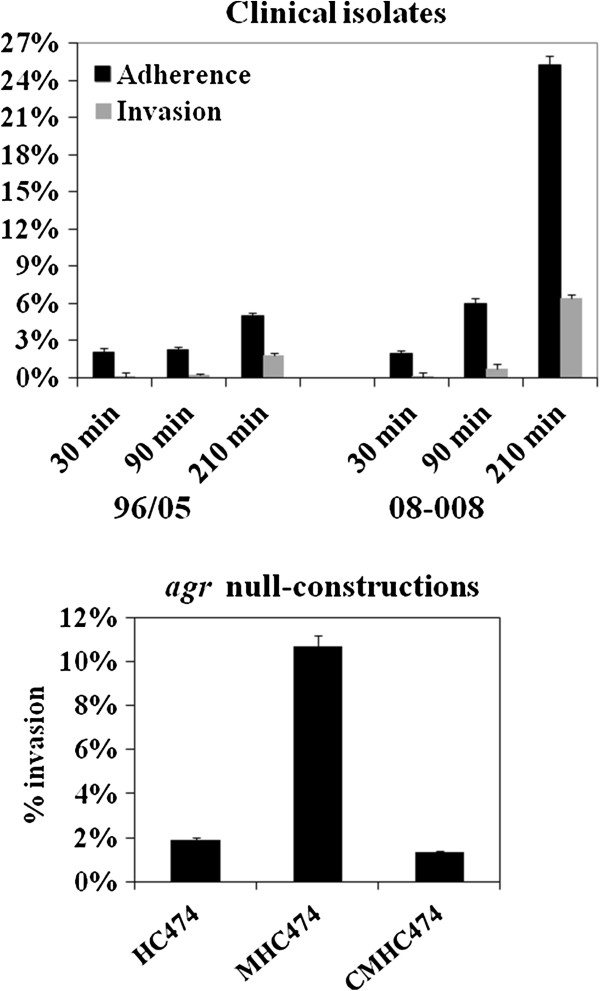
Adherence and invasion assays using human bronchial epithelial cell line (16HBe14o-). Top: 96/05 (agr-functional) and 08–008 (agr-dysfunctional). Bottom: Invasion assay was also determined after 3h30 min for the wild-type strain HC474, isogenic agr knockout MHC474 (Δagr::tetM) and the rnaIII-trans-complemented construction CMHC474 (Δagr::tetM, pbla-rnaIII).